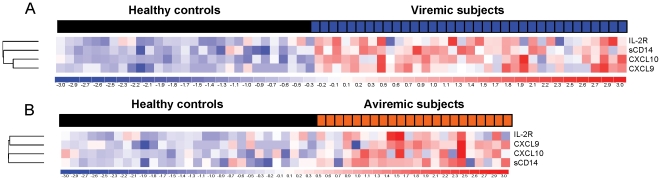
Increased plasma levels of CXCL9, CXCL10, sIL-2R, and sCD14 distinguish viremic and aviremic HIV subjects from controls.Supervised hierarchical clustering of plasma CXCL9, CXCL10, sIL-2R, and sCD14 levels measured in viremic (panel A) or aviremic, (panel B) HIV subjects compared to healthy controls. In heat maps, red and blue represent increased and decreased levels relative to the mean level of a biomarker, respectively. Each column and row defines individual patient and biomarkers, respectively.